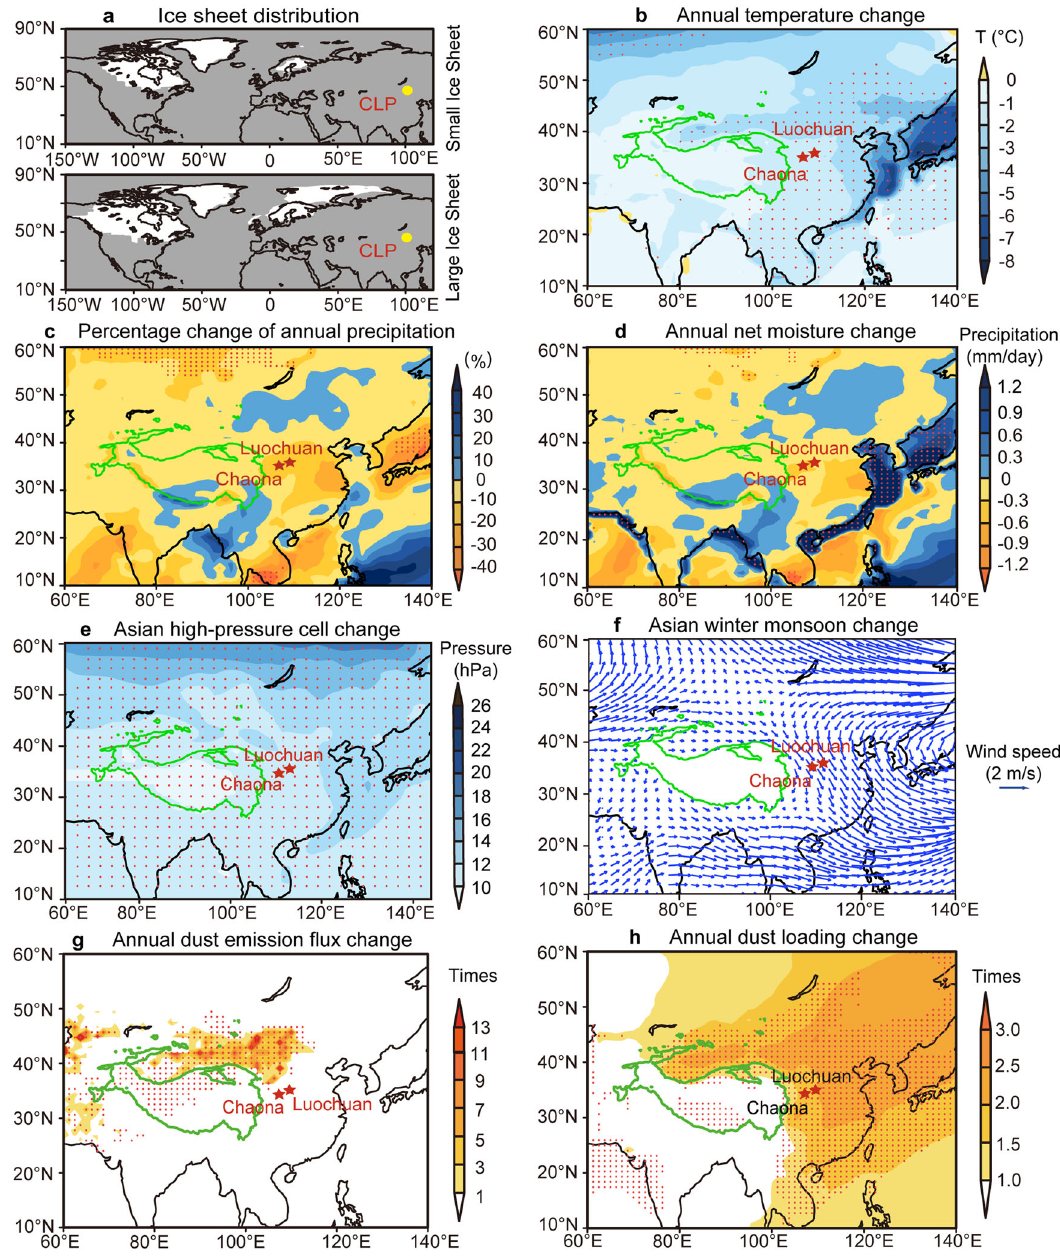
Fig. 6 Simulated Asian climate and atmospheric circulation responses to ice volume increase. a Northern Hemisphere ice sheet distribution used in the Small Ice Sheet (SIS, upper) and Large Ice Sheet (LIS, lower) experiments. The yellow dot represents the Chinese Loess Plateau (CLP). Simulated changes in b annual temperature, c annual precipitation, d annual net moisture (precipitation minus evaporation), e Asian high-pressure cell during winter, and f winter monsoon (700 hPa winds) due to ice sheet expansion (SIS – LIS differences). LIS:SIS ratios of atmospheric g annual dust emission fl ux and h annual dust loading. Solid green contours in b – h denote the 3000 m topographic contour, which includes the Tibetan Plateau. Red stars represent the Chaona and Luochuan loess-palaeosol sections. Small red dots in b – h denote regions with statistical signi fi cance above the 95% con fi dence level (Student ’ s t -test). Winter in the model is represented by December to